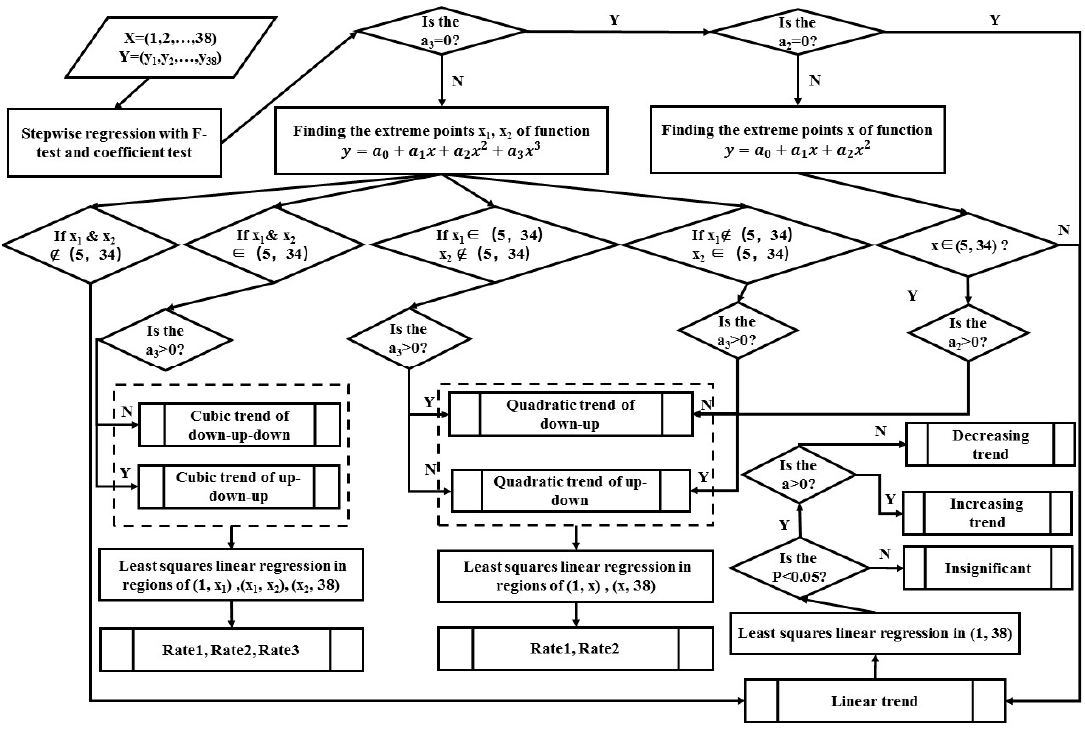
Figure 2. Flow chart of trend recognition.